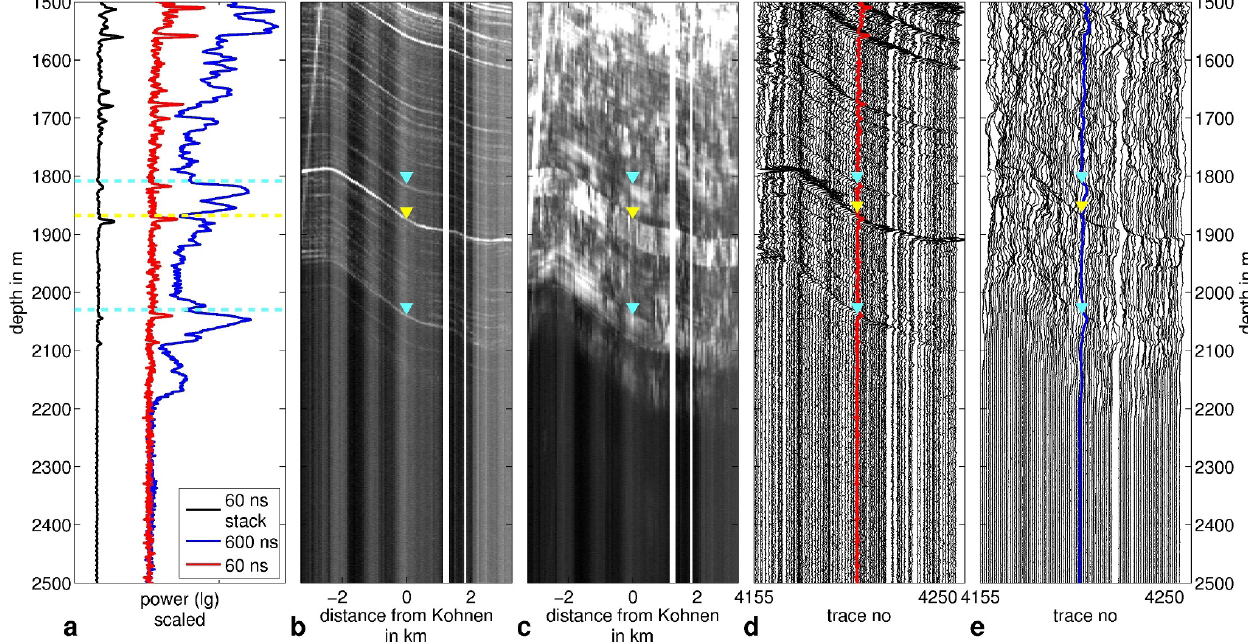
Figure 9. Radar data from Kohnen Station with 60ns pulse (023150) and 600ns pulse (022150) as density plot ( b and c , respectively) and wiggle plot ( d and e , respectively). Subfigure (a) shows the trace closest to the EDML drill location of the 60ns pulse (red) and 600ns pulse (blue) survey, as well as the stack of all traces of survey 033042 (same figure as Fig 8, c ). TWT-depth conversion as in Fig. 8. The light-blue triangle and lines indicate COF-induced reflections (event B and D from Fig. 8), whereas the yellow triangles and line show a conductivity-induced reflection (likely the Toba event at 74ka) for